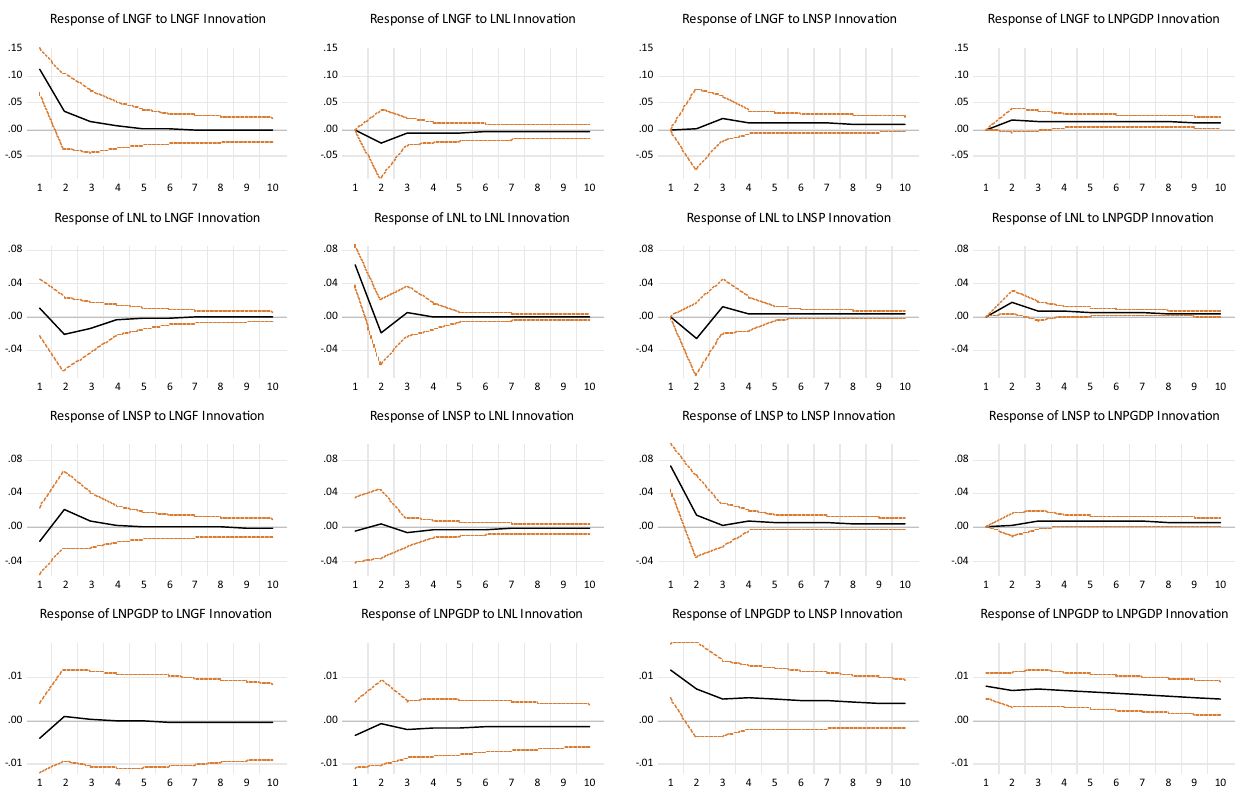
Fig. 3 The results of impulse response analysis of four variables to the long-term structural shocks. Estimates with one standard error band and the red line represents con fi dence intervals were constructed using a recursive-design wild bootstrap, and the black line represents the